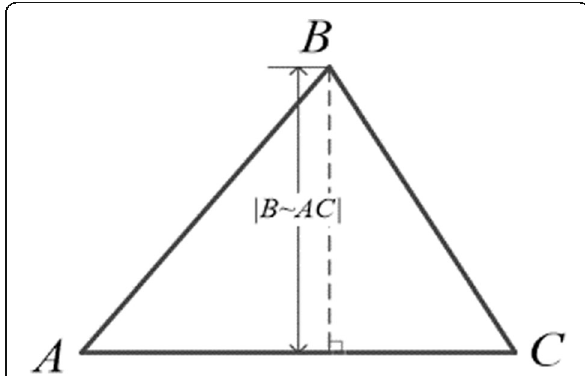
Fig. 2 Schematic diagram of a triangle Δ ABC with a base A C and an apex ∠